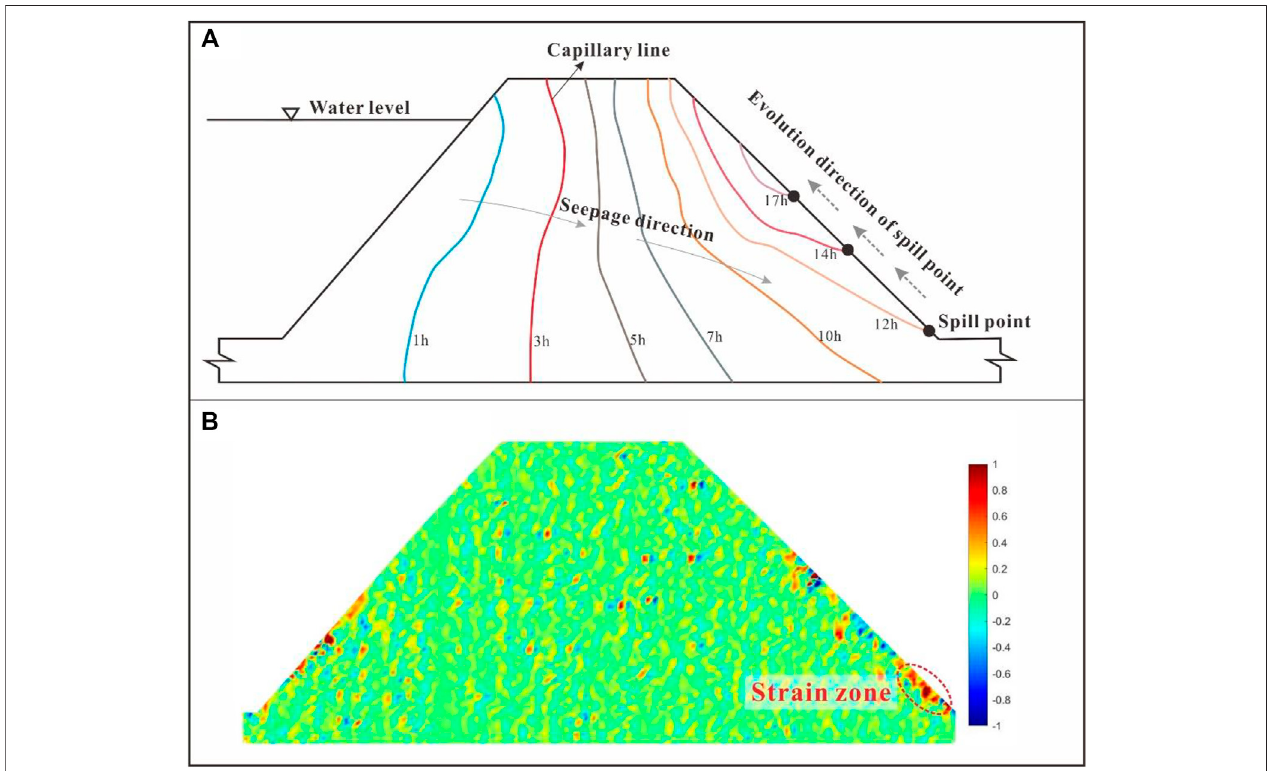
FIGURE6| Evolutionofthecapillarylineinsidethedam. (A) Positionsofthecapillarylineatdifferenttimesduringseepageprocessand (B) strain fi eldofmodeldam during seepage from side view by DIC.